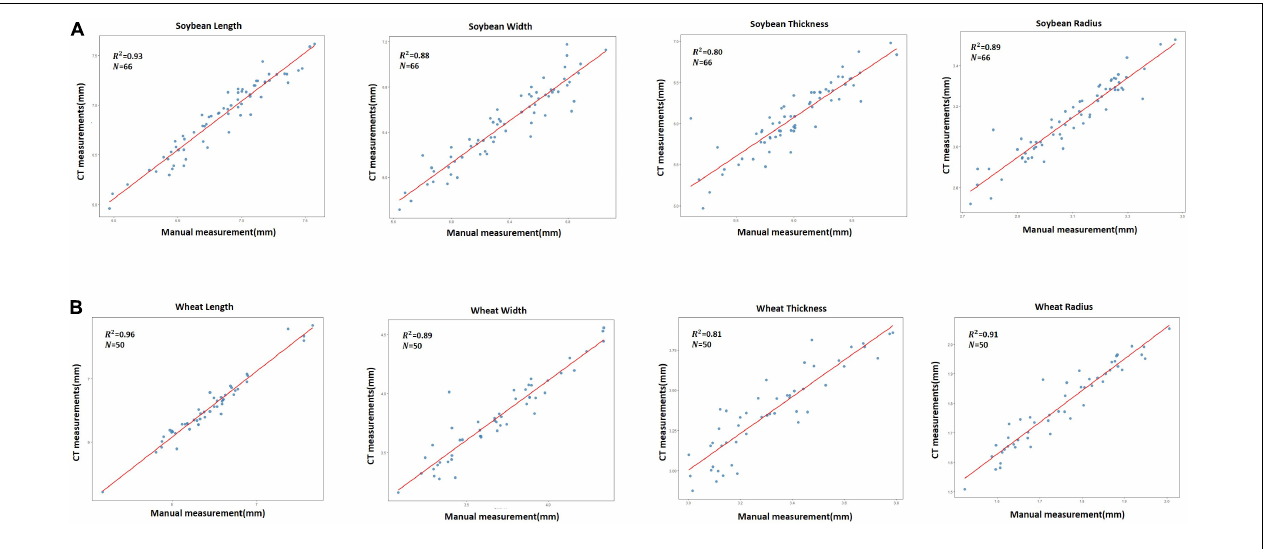
FIGURE 4 | Comparison between the 3DPheno-Seed&Fruit and manually measured phenotypes of seeds using the simple linear regression. (A) soybean; (B) wheat. Each point represents individual seeds. Coefficient of determination ( R 2 ) and number of observations ( N ) are shown in individual scatter